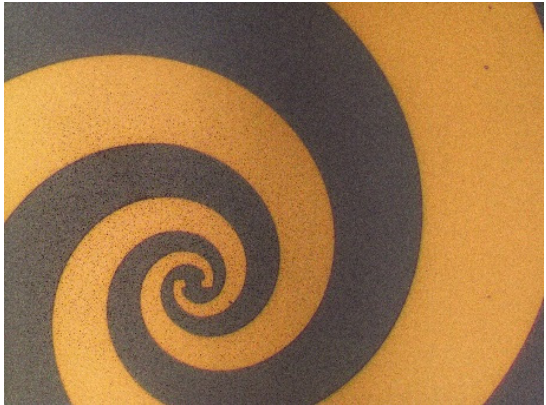
Figure 2. Microscope image of the conventional PCA.